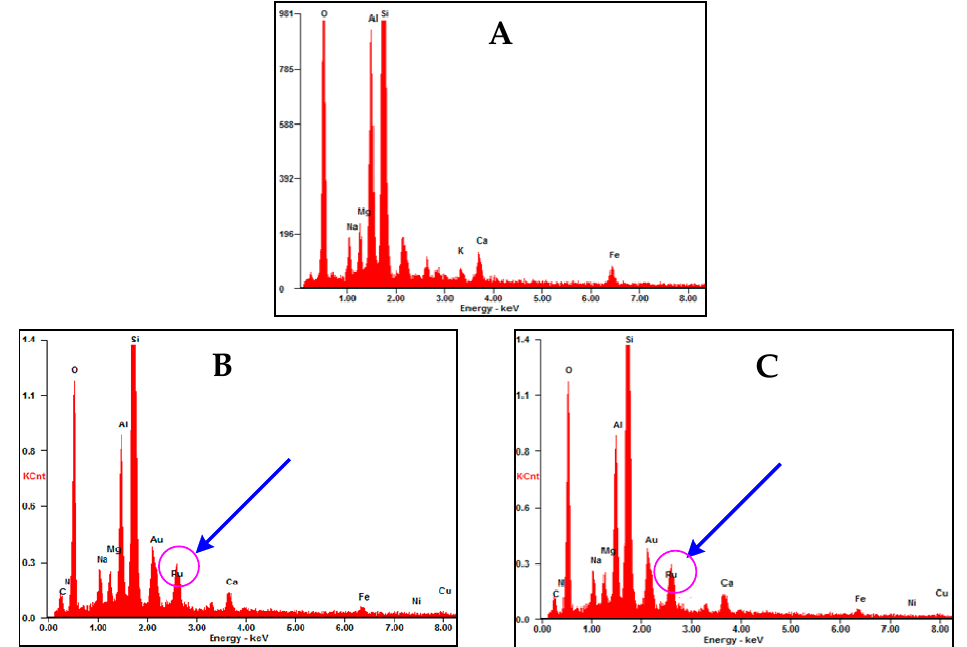
Figure 8. The Energy-dispersive X-ray spectroscopy (EDX) of pure Na-MMT ( A ) can be compared with Ru@MMT-1 ( B ) and Ru@MMT-2 ( C ), identified the existence of Ruthenium content inside the